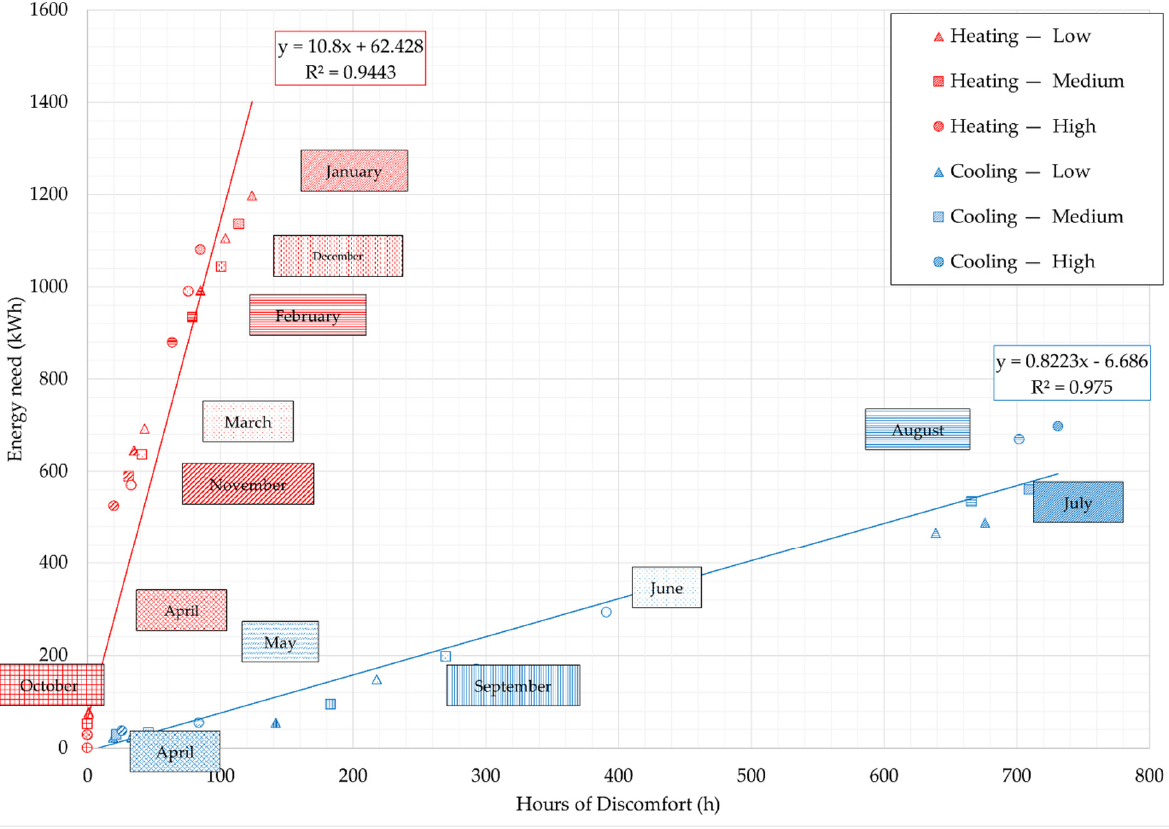
Figure 13. Energy needs for heating and for cooling compared to the hours of discomfort for the three scenarios.